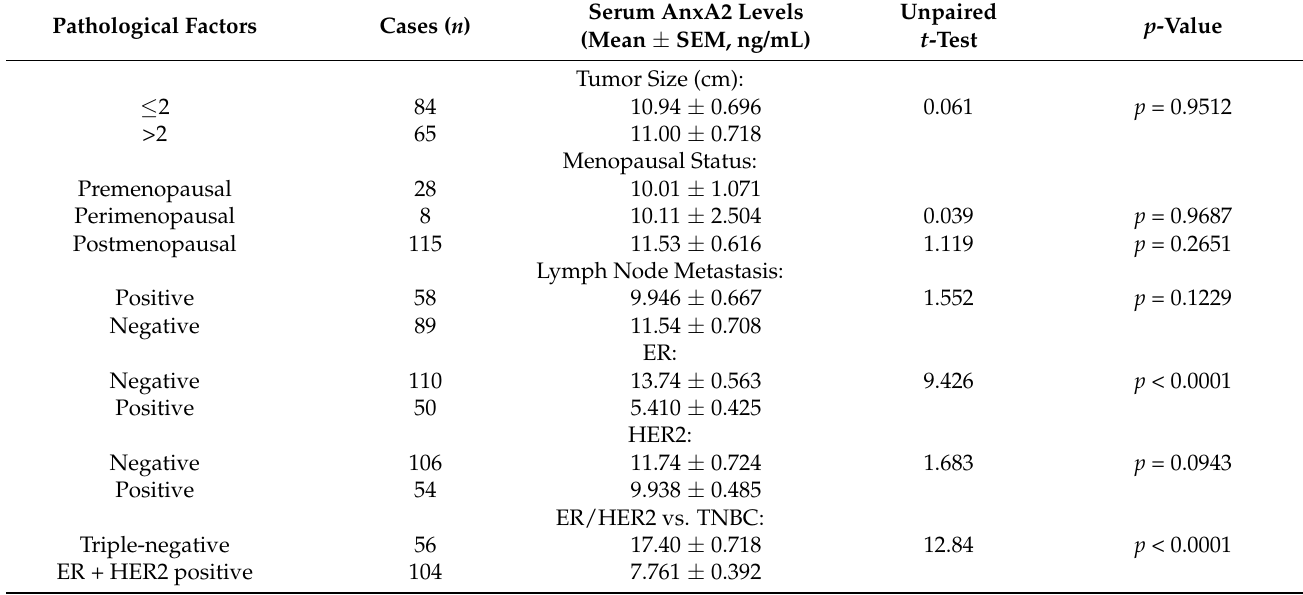
Table 2. The association of serum AnxA2 levels with clinicopathological characteristics in breast cancer patients. Pathological